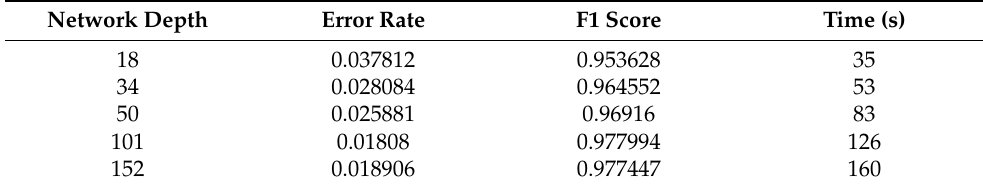
Table 5. Network depth on validation split = 60.